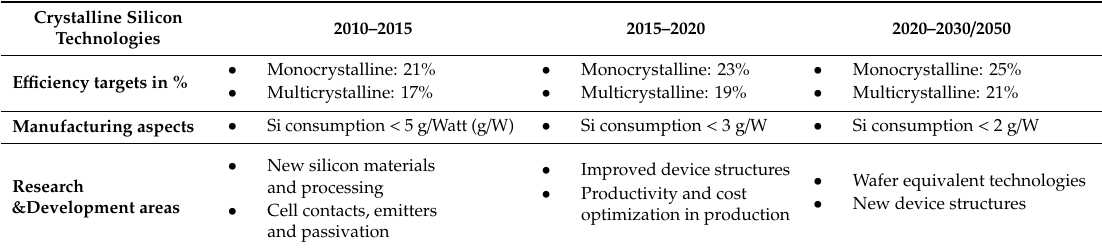
Table6. TechnologygoalsandkeyRandDissuesforcrystallinesilicontechnologies(Source: Technology Roadmap, solar photovoltaic energy, IEA